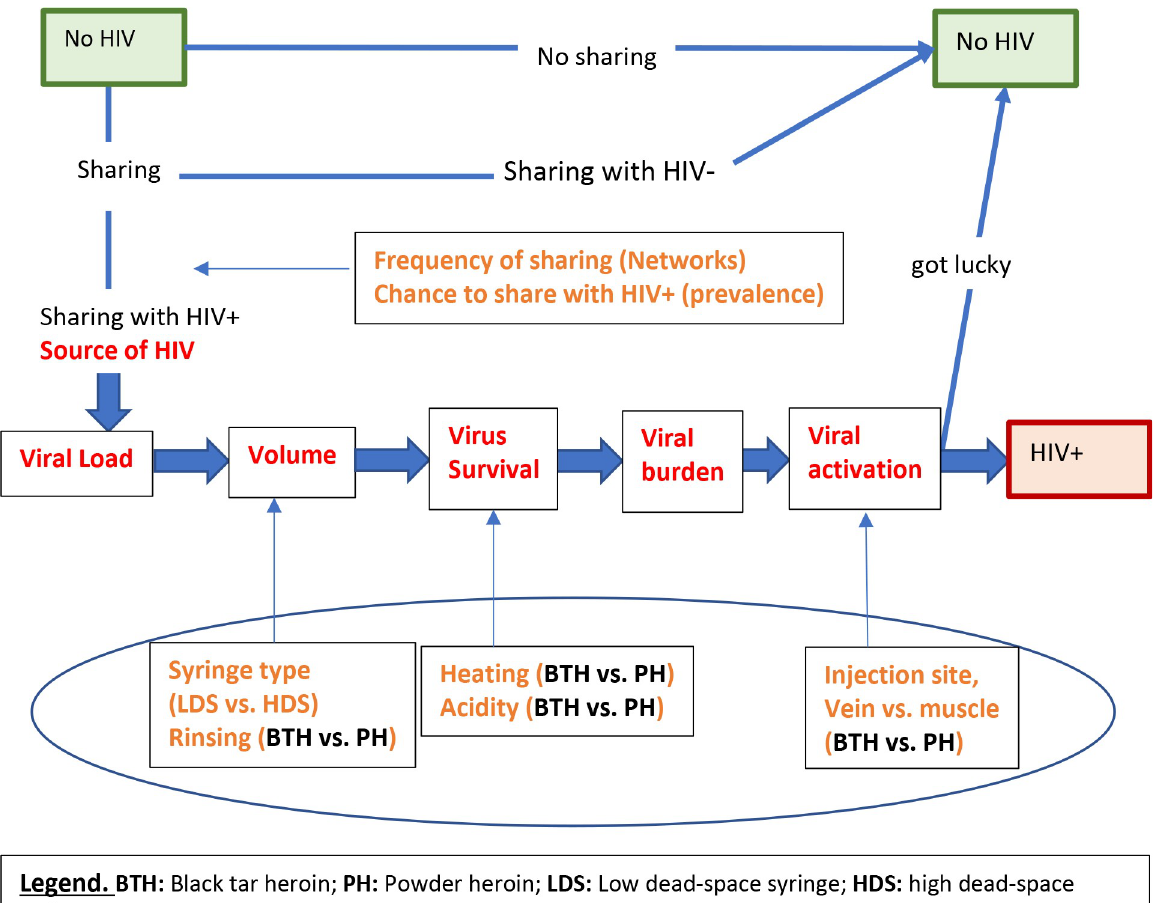
Fig 2. A depiction of factors affecting HIV transmission through sharing syringes and the role of BTH/PH in the probability of transmission. BTH/PH factors are overlaid with the oval.